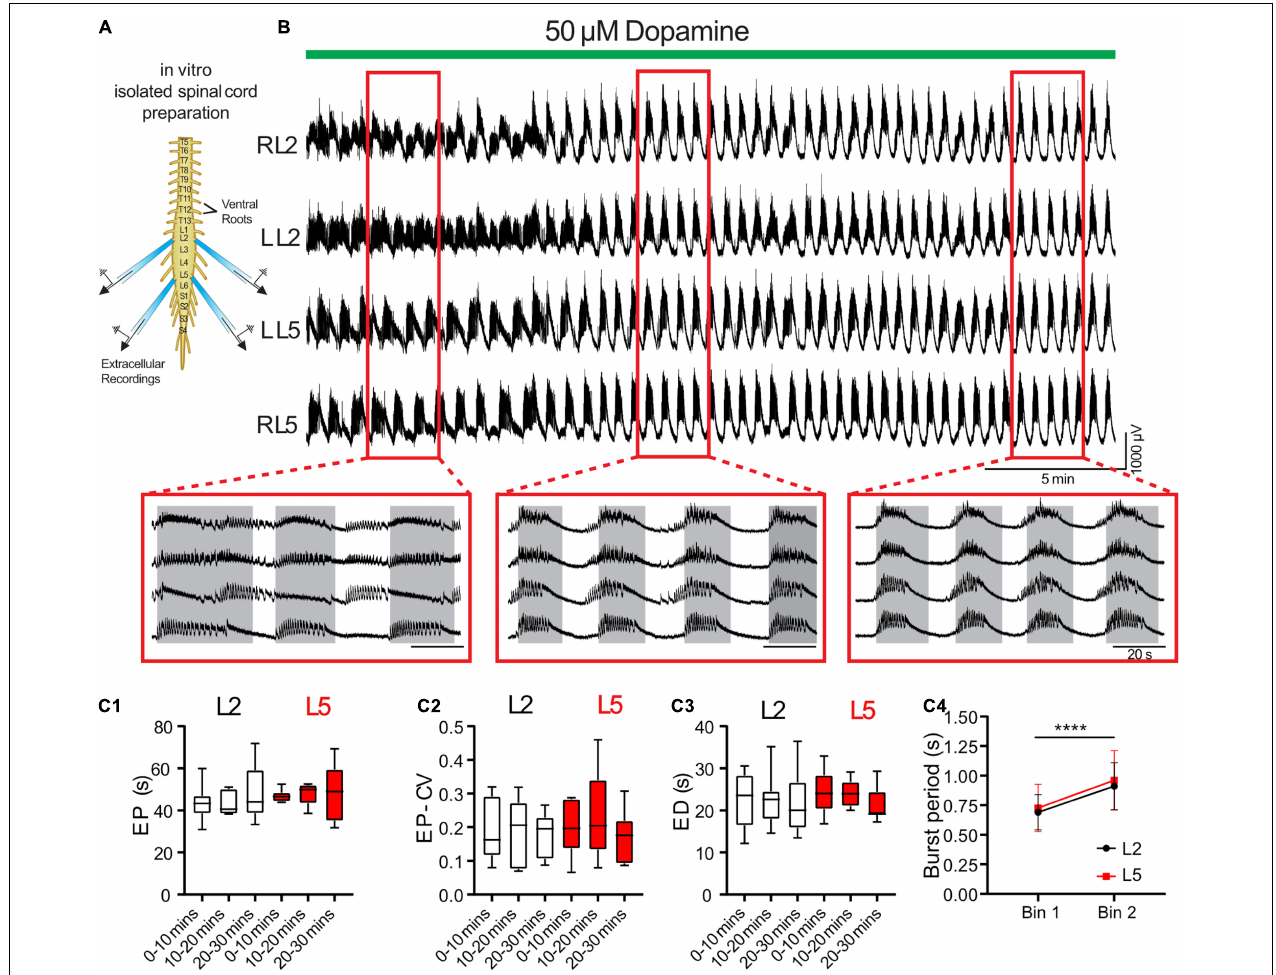
FIGURE 3 | Dopamine elicits episodic bursting in isolated spinal cords of newborn mice. (A) Suction electrodes were used to record extracellular neurograms from left (L) and right (R) ventral roots of the second (L2) and fifth (L5) lumbar segments. (B) Dopamine applied at 50 µ M (green bar) evoked episodic rhythmicity in lumbar spinal circuits. Expanded red boxes highlight changes in episode patterning across ventral roots over time. (C) From 0 to 30 min after dopamine application, episodes did not differ between L2 and L5 in episode period (EP: C1 ), episode period coefficient of variation (EP-CV: C2 ) or episode duration (ED: C3 ). Box and whisker plots display interquartile range (boxes), median (horizontal black lines), maximum, and minimum values in data range (whiskers). (C4) The burst period of the intra-episode rhythm increased between the first (bin 1) and second (bin 2) halves of an episode. Data in (C4) are presented as mean ± SD during the first (Bin 1) and second (Bin 2) half of each episode. Asterisks denote significance (**** p < 0.0001, n = 8) from post hoc analyses following a 2-way